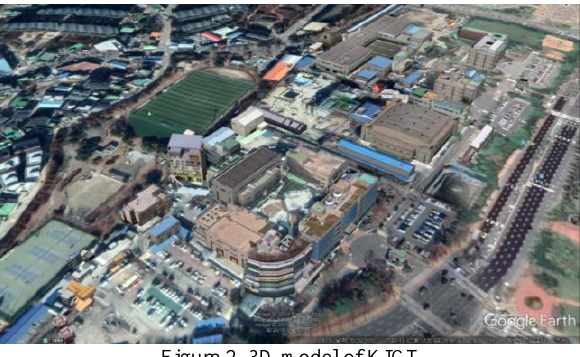
Figure 2. 3D model of KICT